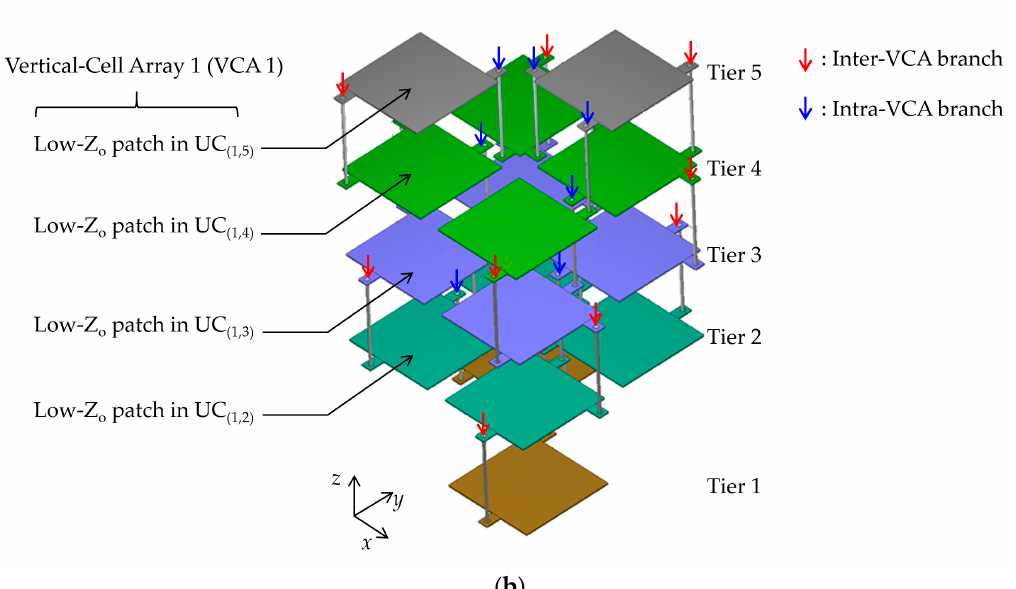
Figure 2. ( a ) Illustration of the compact and multi-stack electromagnetic bandgap (CMS-EBG) structure with vertical-cell array (VCA) branches (the ground vias are not shown for simplicity) and ( b ) highlighted view of the patches and VCA branches of the power layers.